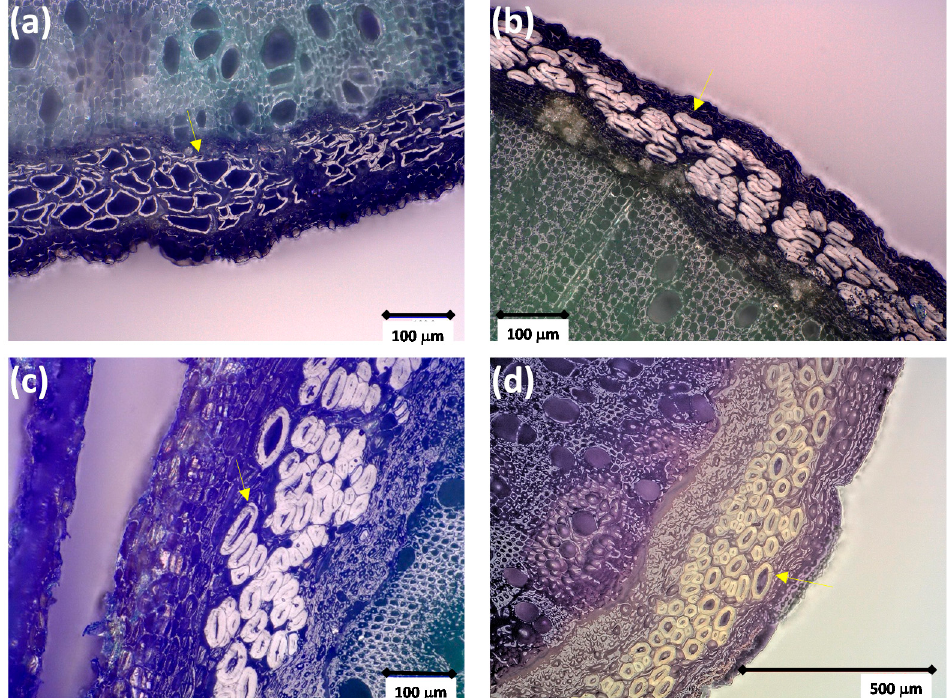
Figure 4. Transverse cross-sections of wild nettle stems harvested in Saint-Symphorien (France, Bourgogne-Franche-Comté region (lat. 47°5 ′ 5.98 ″ N. 5°19 ′ 44.0322 ″ E) in 2019 at different times between May ( a ), June ( b ), July ( c ), and August ( d ). Arrows point out some examples of primary bast